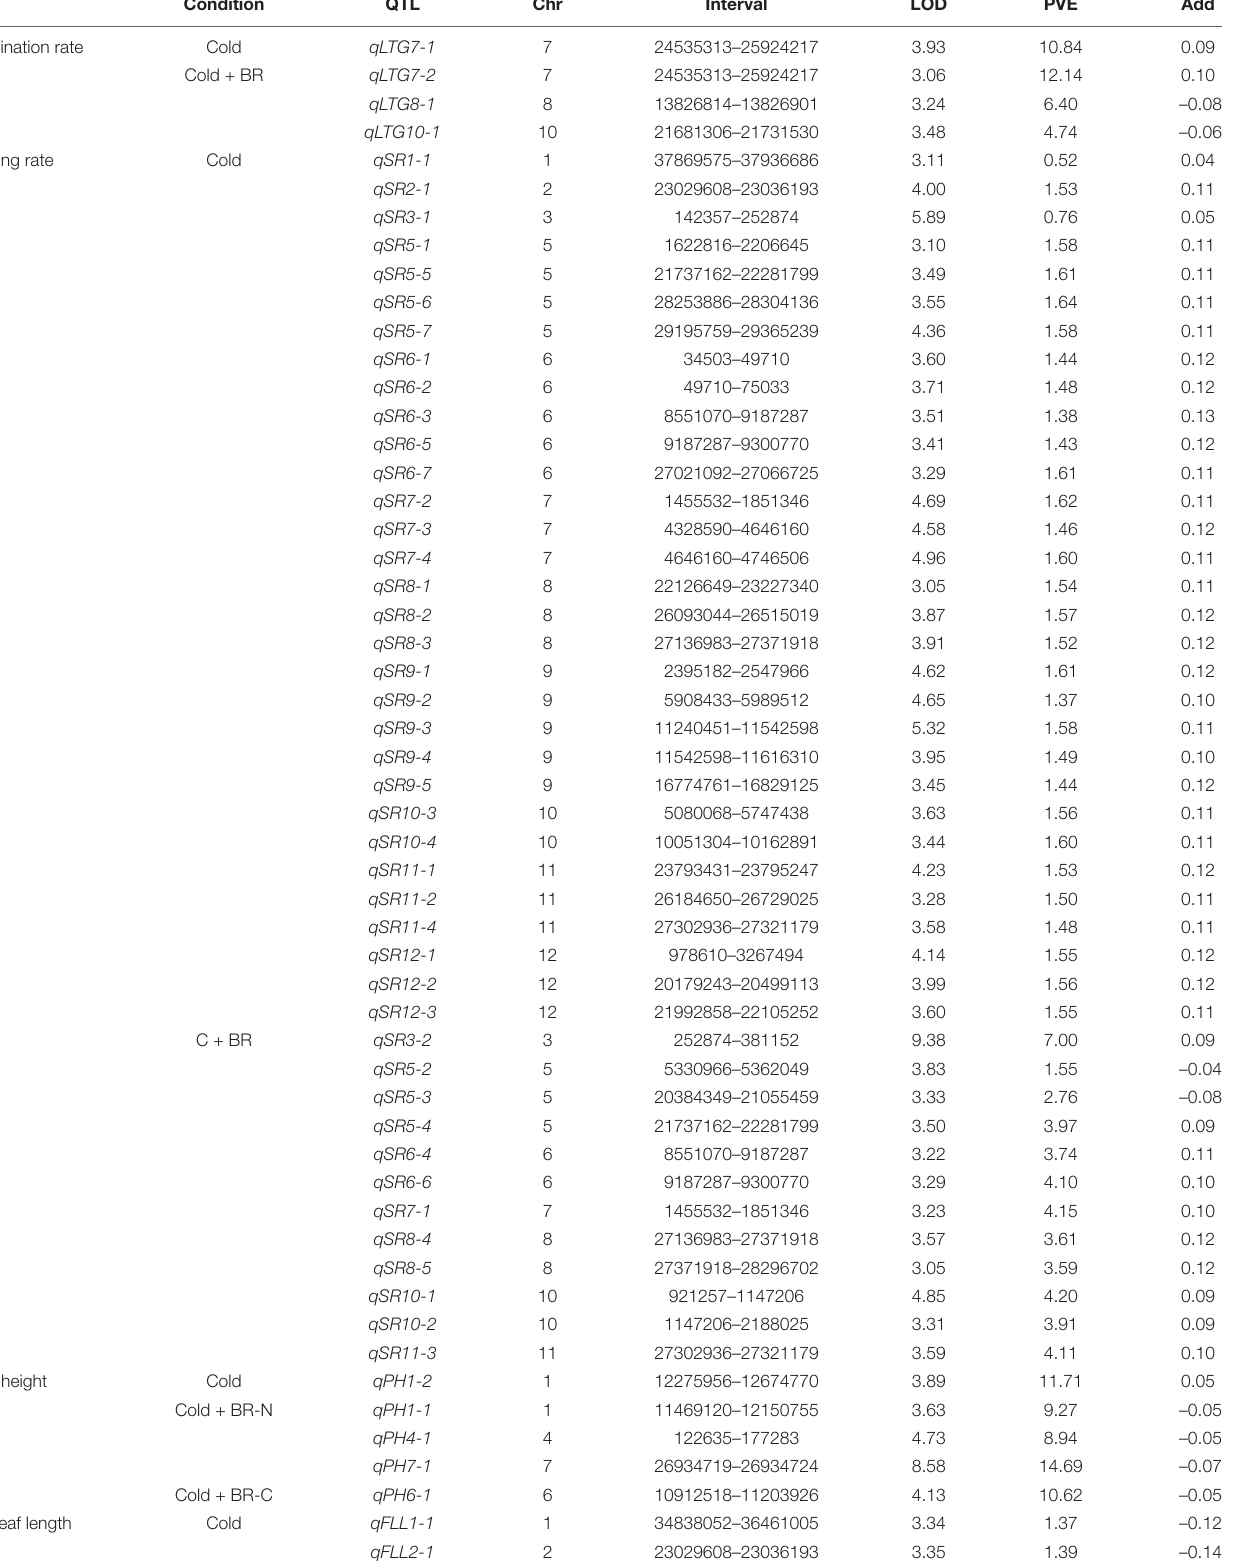
TABLE 2 | QTL summary under different conditions for four traits.